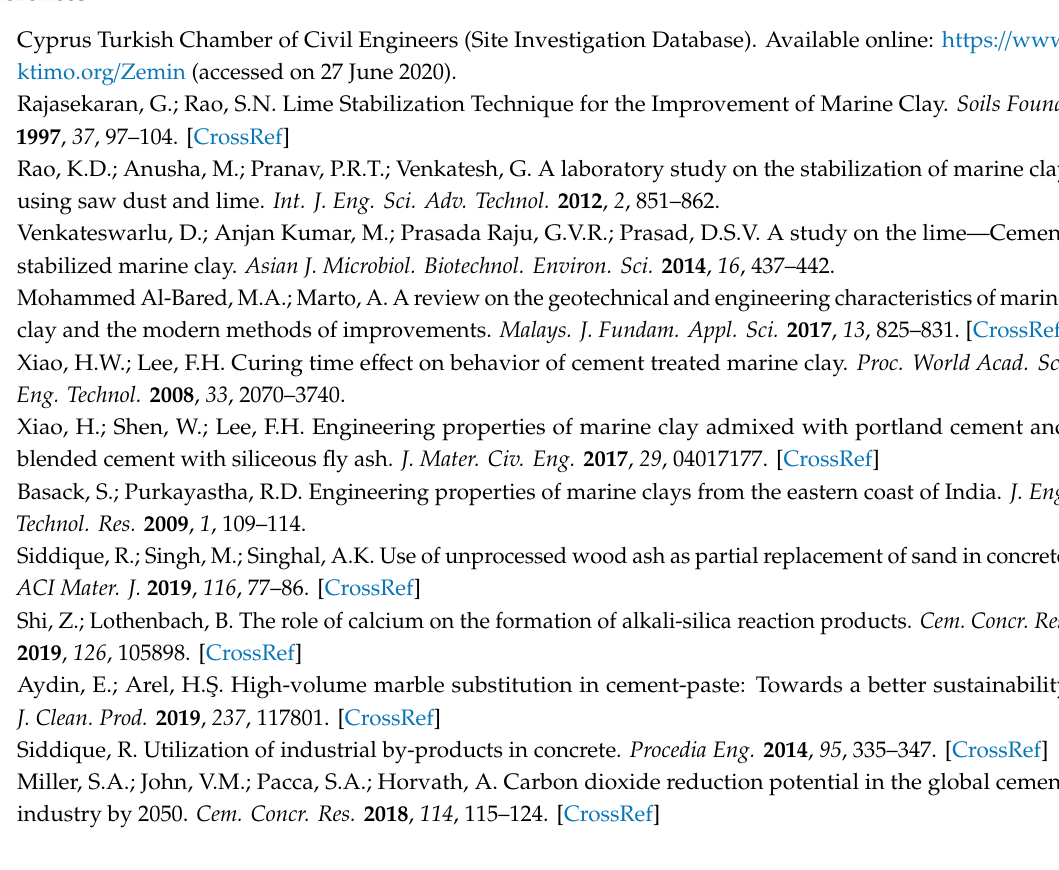
Figure S1: Compaction curve of the clay used with the two chosen densities. Figure S2: EDX analysis: Resulting spectrum and tabulated results of marine deposited clay. Figure S3: EDX analysis: Resulting spectrum and tabulated results of